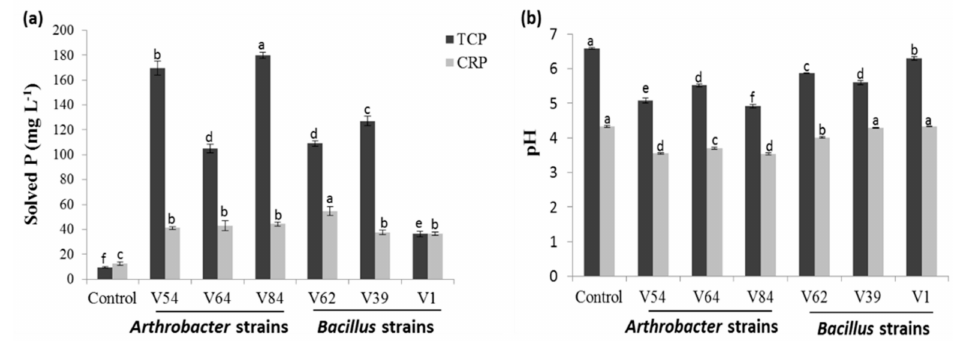
Figure 2. The e ffi ciency of bacterial strains to solubilize inorganic phosphate sources in liquid culture. ( a ) Amount of P (mg L − 1 ) released from tricalcium phosphate (TCP) and Cameroonian RP (CRP). ( b ) Accompanying pH changes induced by isolates of National Botanical Research Institute’s Phosphate (NBRIP) medium supplemented with the two phosphate sources without additional salt stress (right hand side). Data are the means of three replicates and error bars represent the standard